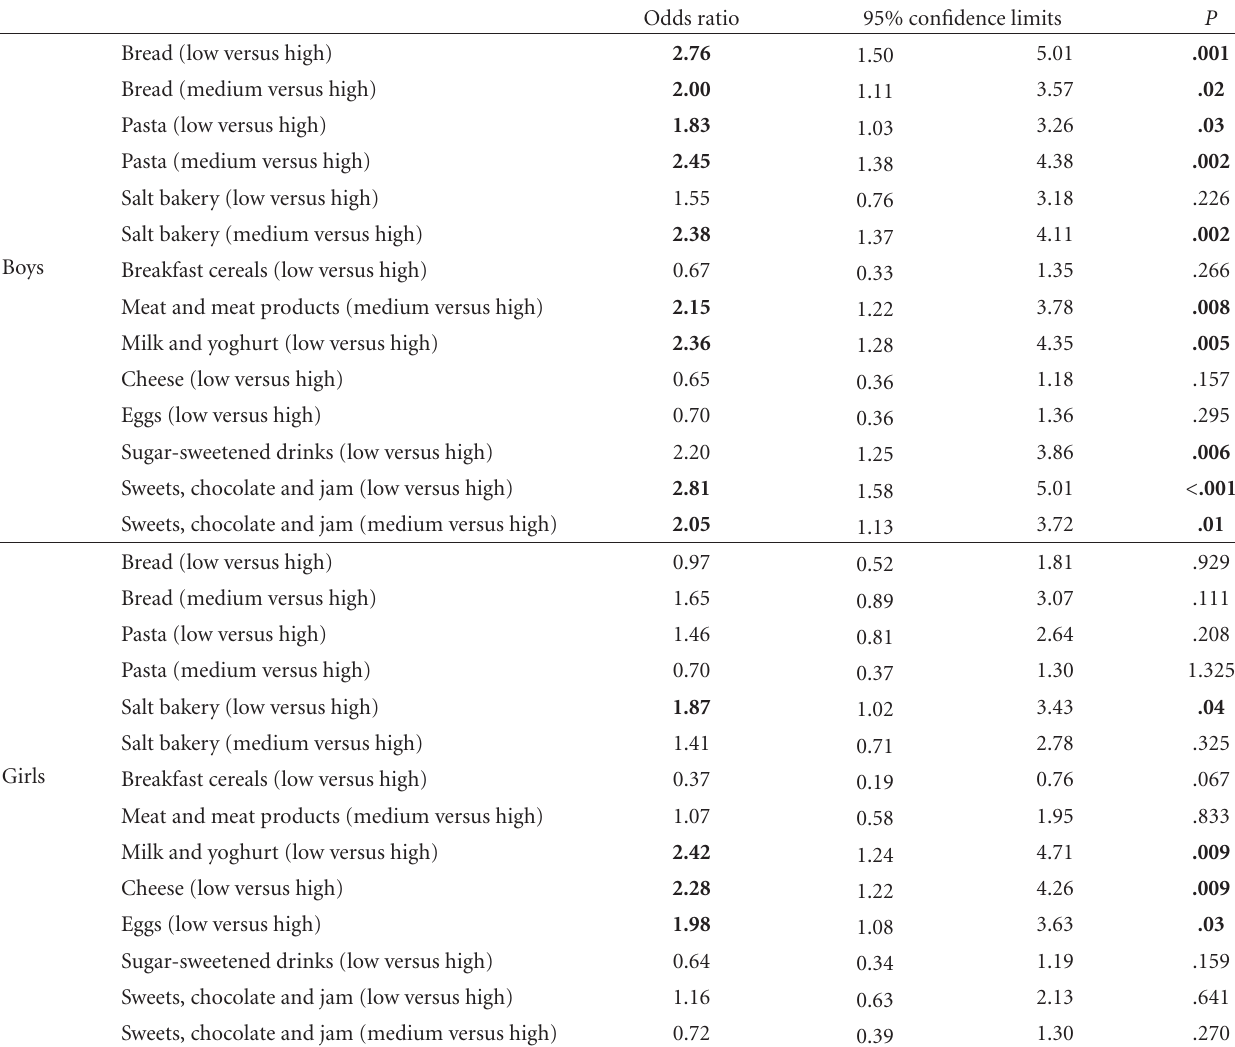
Table 4: Food consumption in relation to overweight status: results of multiple logistic regression. Odds ratio 95% confidence limits P Bread (low versus high)